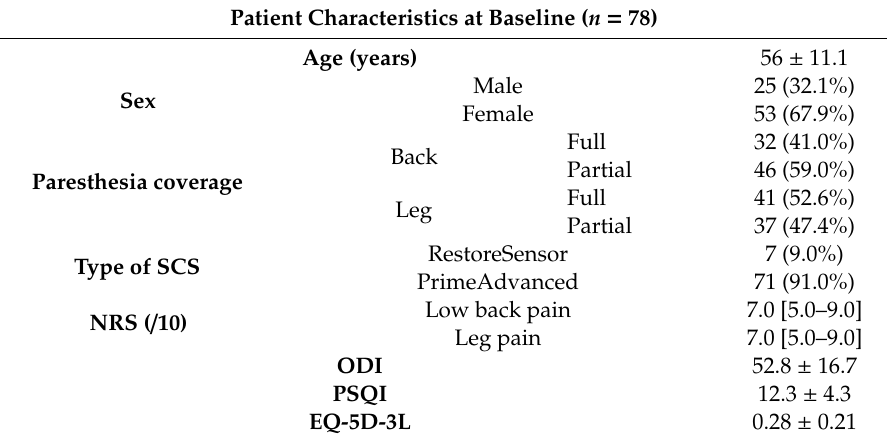
Table 1. Patient characteristics at